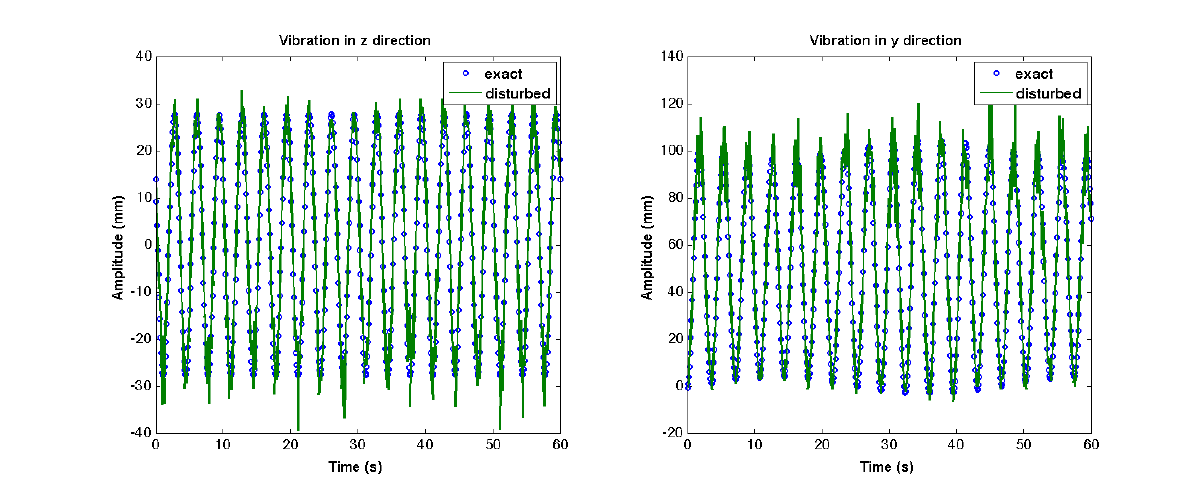
Figure 8 . Exact vibration and disturbed vibration in the top of the tower.